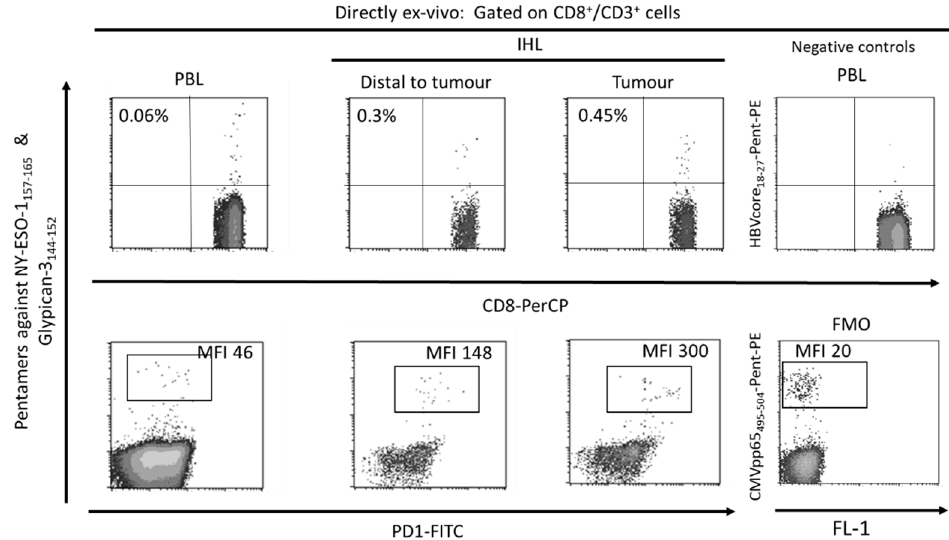
Figure 2. Flow-cytometric analysis of peripheral blood and intrahepatic lymphocytes in a patient with a Barcelona Clinic Liver Cancer Stage B hepatocellular carcinoma with hepatitis C cirrhosis, HBV negative, CMV positive. The ex-vivo CD8+ T cell response against the HLA-A2 restricted HCC epitopes Glypican-3 144–152 and NY-ESO-1 157–165 was tested by staining with CD8, CD3 and HLA-I pentameric complexes loaded with specific peptides. A tumoral sequestration of HCC-specific CD8 T cells and a PD-1 up-regulation gradient between peripheral blood and tumor was observed. PBL: peripheral blood lymphocytes, IHL: intrahepatic lymphocytes, MFI: mean fluorescence intensity, FMO: fluorescence minus one.